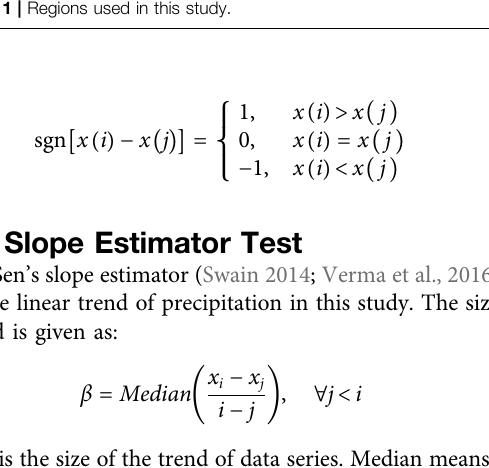
FIGURE 1 | Regions used in this study.